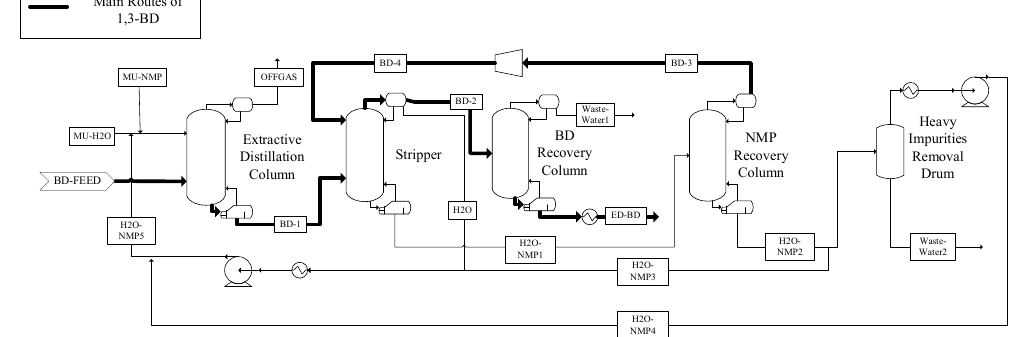
Figure 4. The 1,3-BD purification unit used for the extractive distillation process.